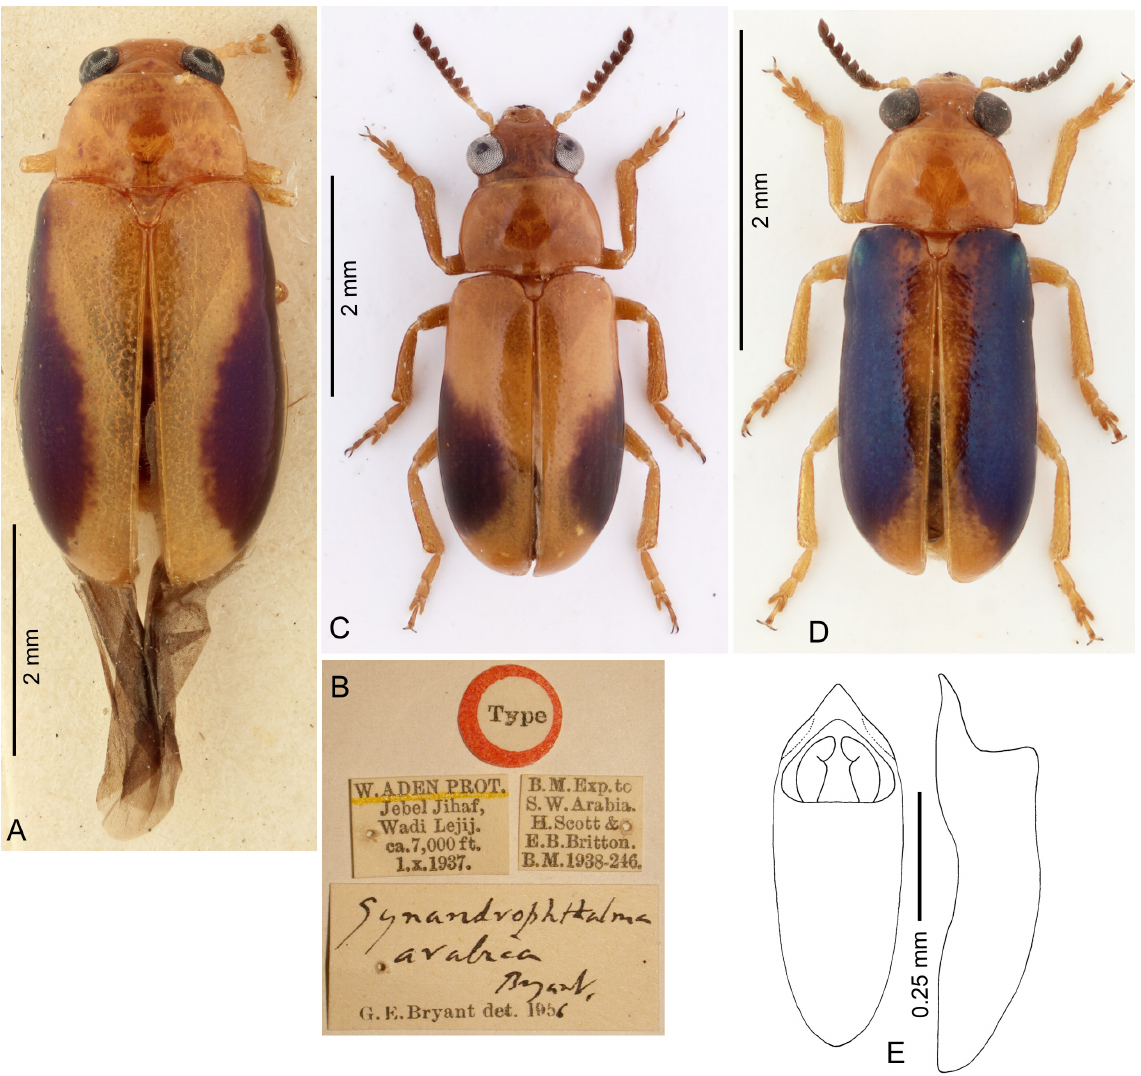
Fig. 12. Afrophthalma arabica (Bryant, 1957). A – B . Holotype, ♀, 4.5 mm (BMNH). A . Dorsal view. B . Labels. C . ♂, 4.2 mm, Oman (JBCB). D . ♂, 3.2 mm, Yemen (JBCB). E . Aedeagus in dorsal and lateral